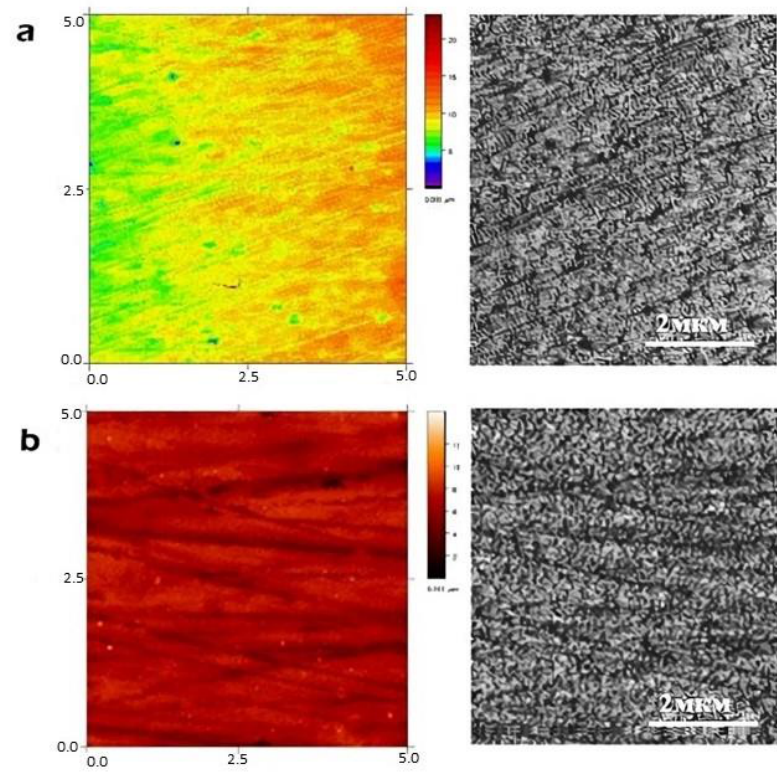
Figure 2. Height profiles in films without filler ( a ) and with ZnO filler ( b ).